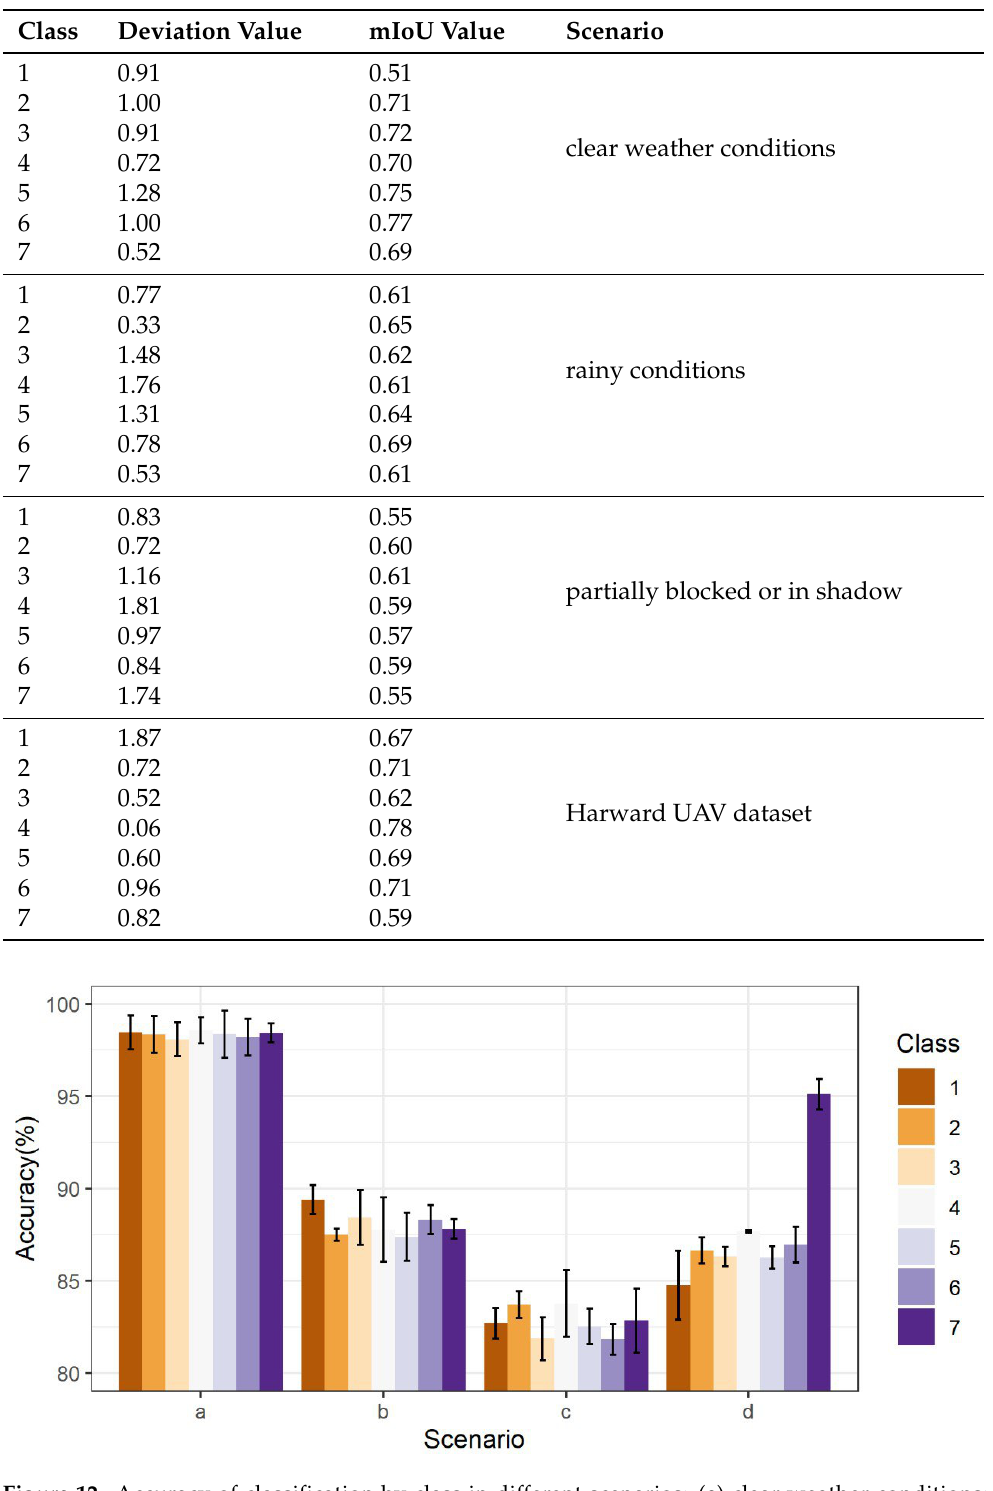
Table 1. Calculated deviation and mIoU values.